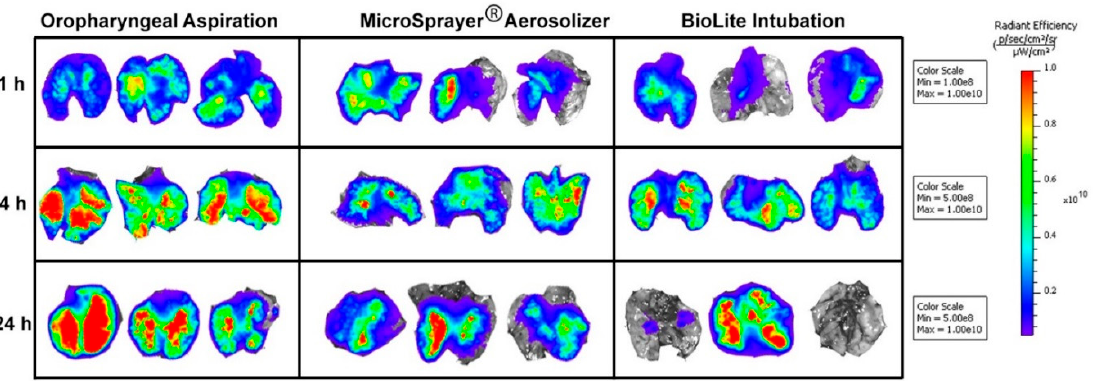
Figure 7. Images of excised lungs of mice acquired using IVIS Spectrum at 1, 4, and 24 h after pulmonary administration of near-infrared fluorescent Degradex ® poly(D,L-lactide-co-glycolide) (PLGA) microspheres using oropharyngeal aspiration, the MicroSprayer ® Aerosolizer, and the BioLite Intubation System.